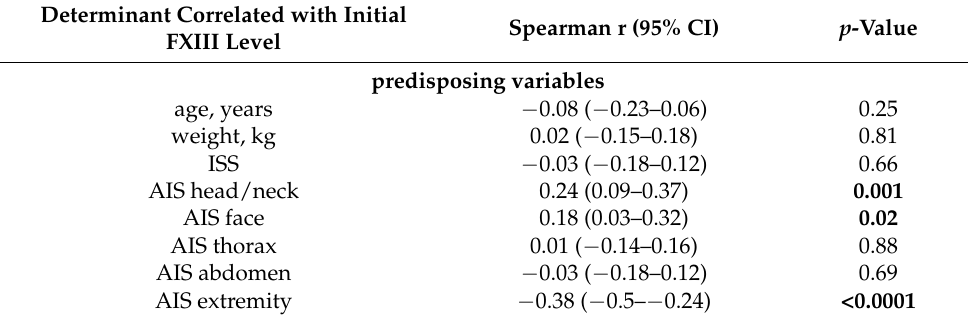
Table A1. Correlations between determinants and the initial FXIII